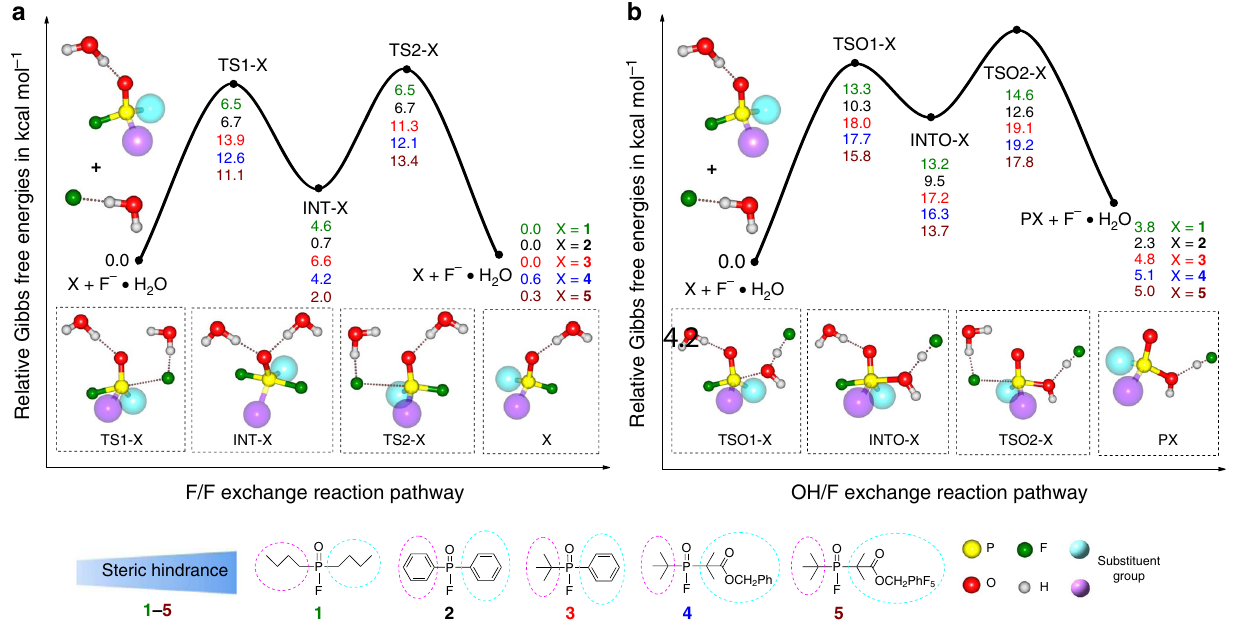
Fig. 2 Mechanism of H 2 O-resistant 18 F/ 19 F exchange interpreted by free energy parameters. Geometries are optimized at the B3LYP/6-31 + G* level of theory, and single point calculations are performed at the CAM-B3LYP/6-311 ++ G** level of theory. Two substituent groups on the phosphorus center are simpli fi ed as two large spheres in the molecular structures for clarity. a Reaction pathways and free energy (kcal mol − 1 ) pro fi les for the F/F isotope ve selected reactant fi ve representative organophosphine fl uorides ( 1 – 5 ). Detailed